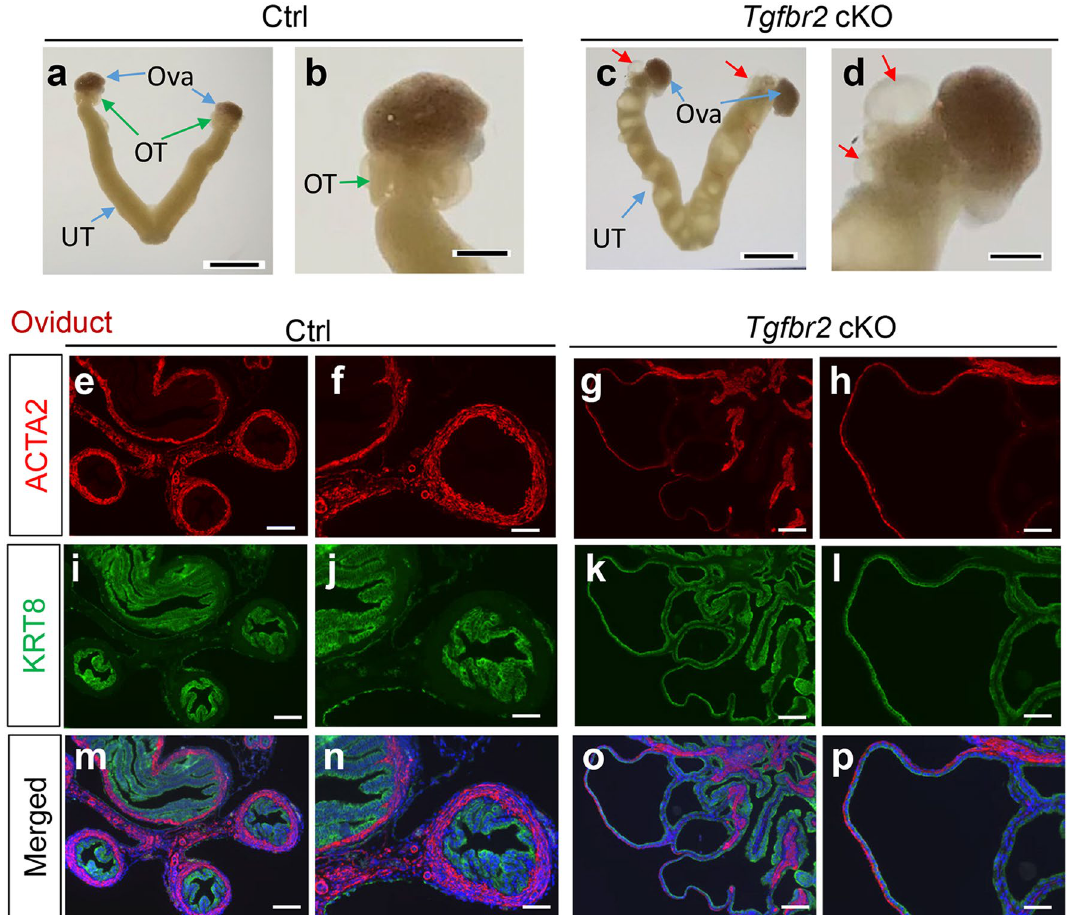
Figure 3. Formation of oviductal diverticula in Tgfbr2 cKO. ( a – d ) Representative images of the reproductive tract from controls and Tgfbr2 cKO at 3 months of age. UT, uterus; OT, oviduct; Ova, ovary. Red arrows in ( c ) and ( d ) indicate the diverticula. Scale bar = 4 mm ( a , c ) and 1 mm ( b , d ). ( e–p ) Double indirect immunofluorescence of ACTA2 and KRT8 staining using oviducts from controls and Tgfbr2 cKO at 3 months of age. ( f , h , j , l , n , p ) Are higher magnification images for ( e , g , i , k , m , o ). Three independent mice were examined for each genotype. Scale bar equals 50 µm ( f , h , j , l , n , p ) and 100 µm ( e , g , i , k , m , o